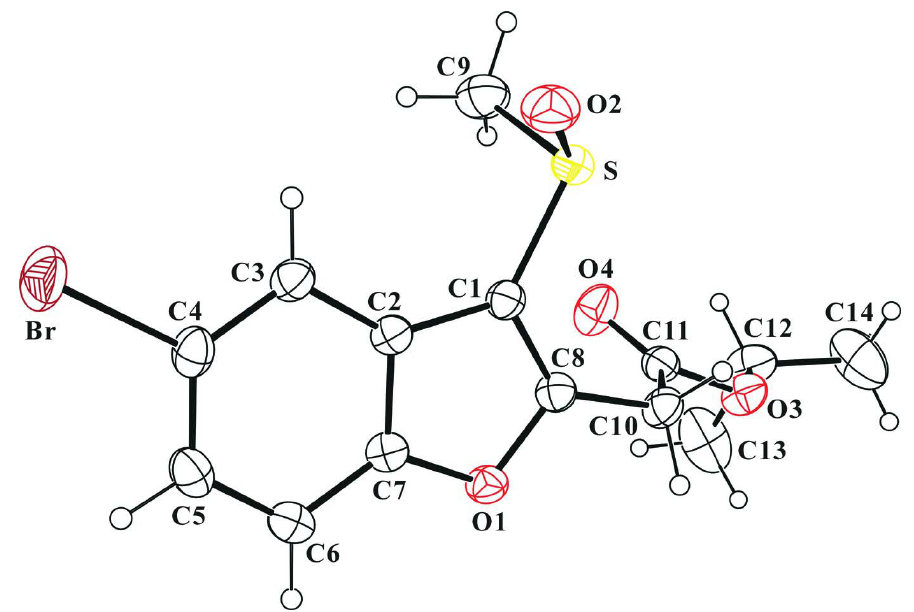
Figure 1 The molecular structure of the title compound, showing displacement ellipsoids drawn at the 30% probability